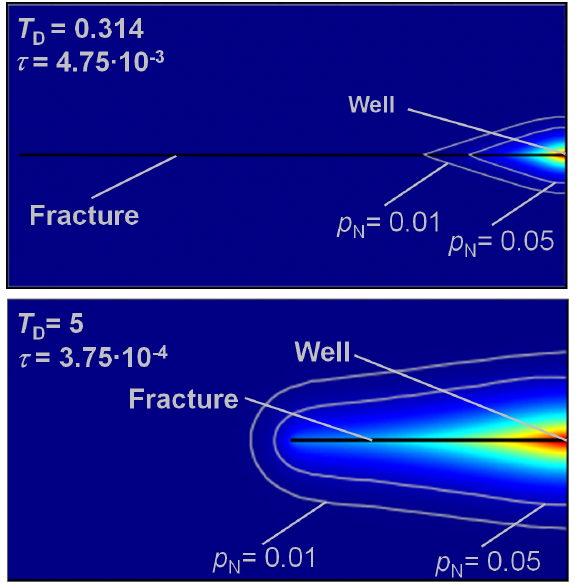
Fig. 3. Snapshots of the normalized pressure field p N for fractures with dimensionless fracture conductivity of T D = 0 . 314 (top) and T D = 5